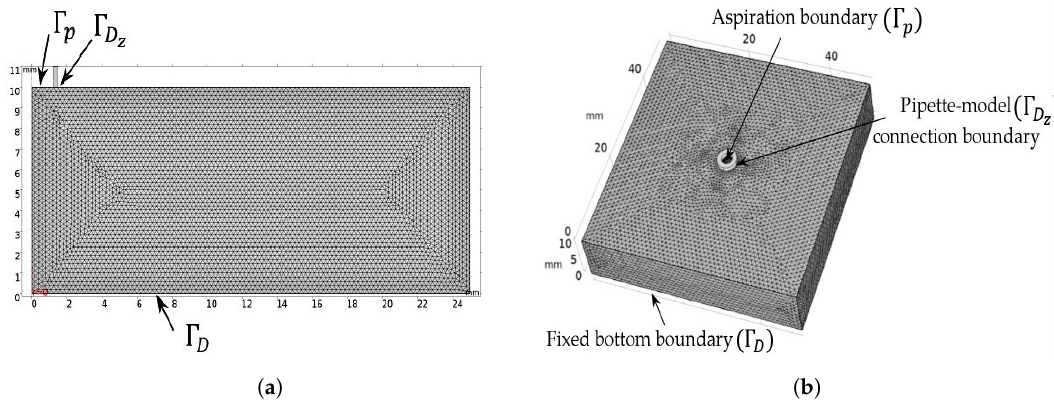
Figure 4. Geometry of the Model; ( a ) 2D model from the z – y cross-section of the 3D model; ( b ) 3D model based on the experimental